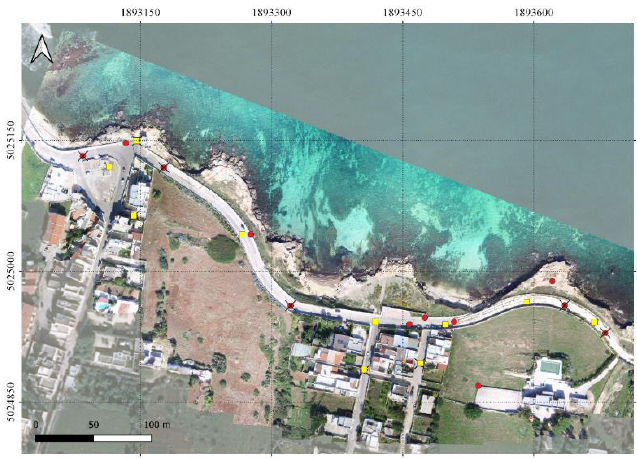
Figure 1. Study area depicted by using the textured orthophoto generated from the photogrammetric datasets acquired on October 16th, 2019, overlapped on a Bing Satellite Map (EPSG:3857 - WGS84/Pseudo-Mercator). Points measured in the GNSS survey campaign in the three analysed scenarios: i) Indirect Georeferencing with 20 GCPs (red dots), ii) Indirect Georeferencing with 10 GCPs (marked red dots), Direct Georeferencing. CPs (yellow dots) in the three